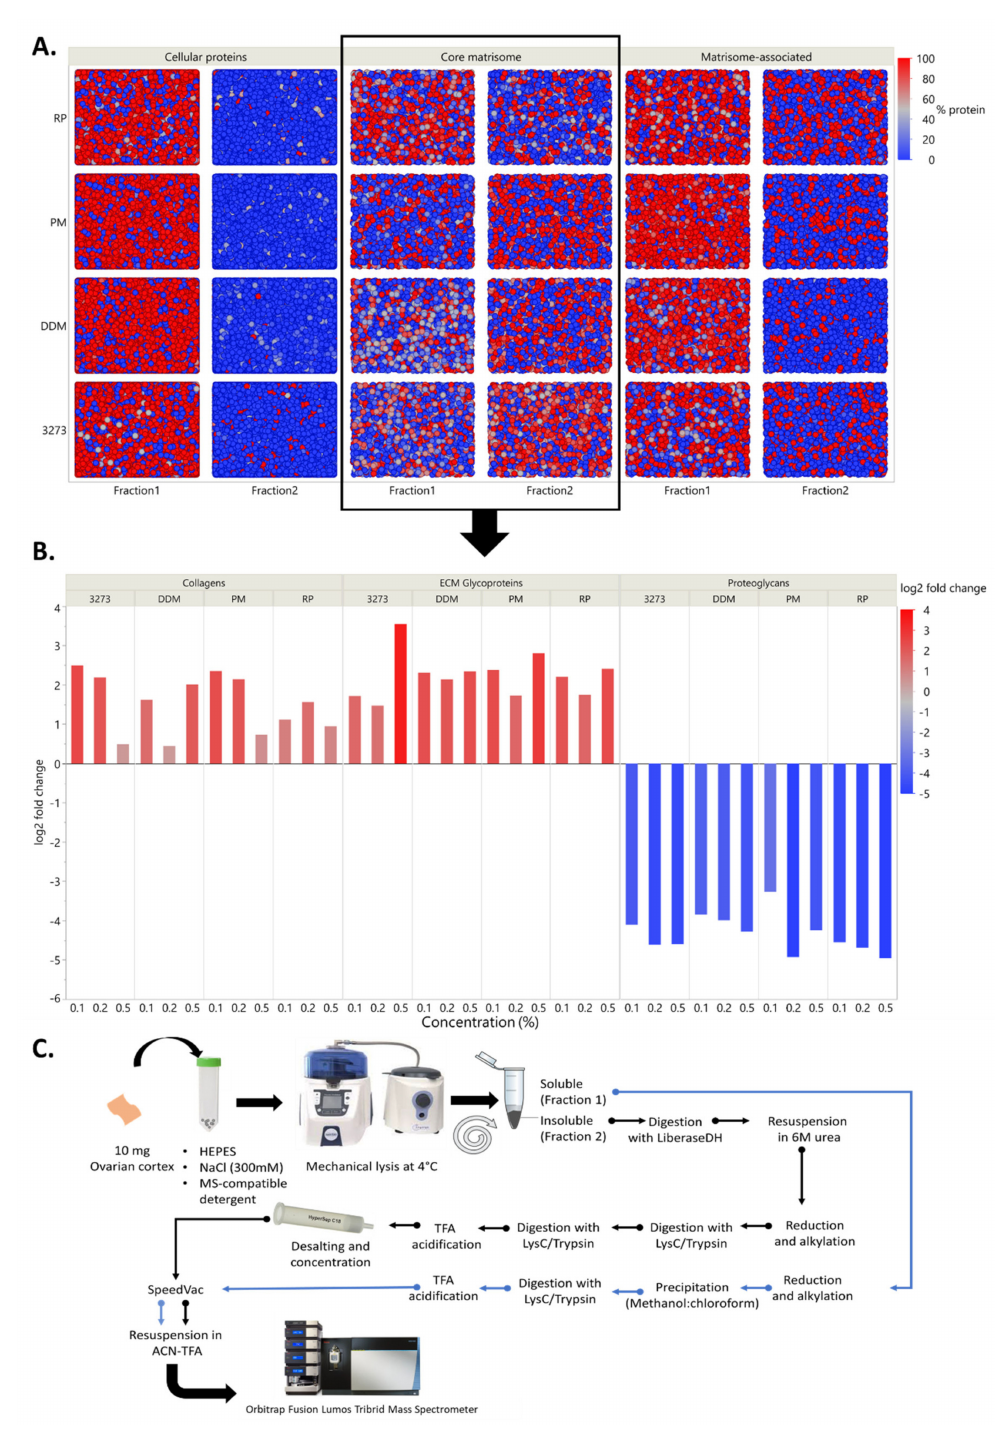
Figure 2. Two-step fractionation impact on the segregation of cellular protein, core matrisome and matrisome-associated proteins. ( A ) Scatter plot of proteomic data according to the protein percentage in each fraction; each dot represents a protein and the color key reflects its relative abundance per fraction. Matrisome data (framed) have been explored deeper in B. ( B ) Enrichment of collagen and glycoproteins in all conditions in fraction 2 expressed as the log2 fold change in XICs. ( C ) Summary of the two-step fractionation approach (DC-MaP